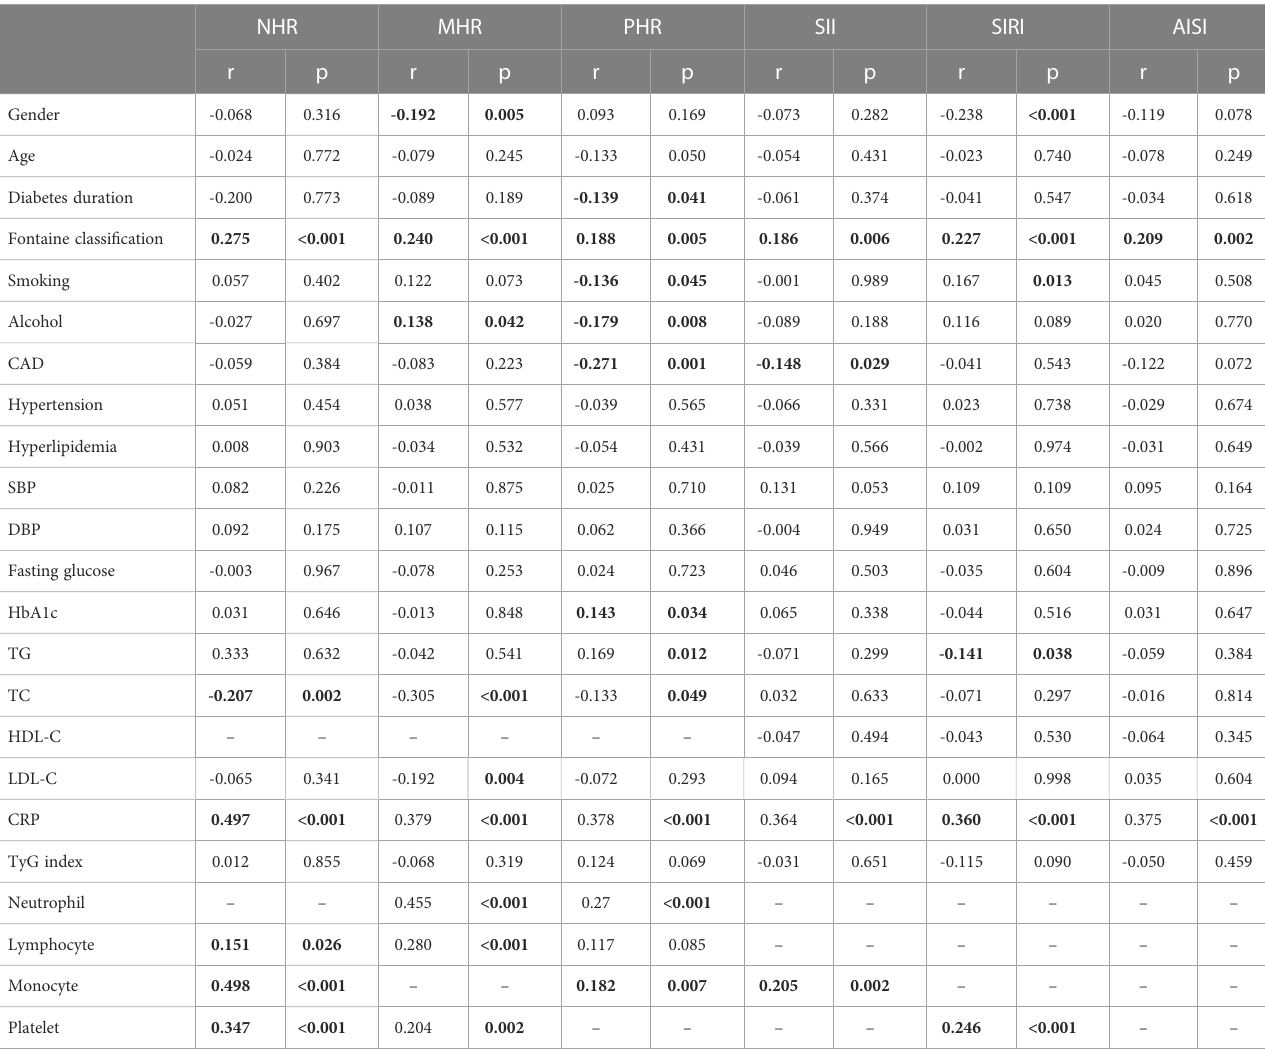
TABLE 4 Correlation of the in fl ammatory biomarkers with other parameters in the T2DM-PAD